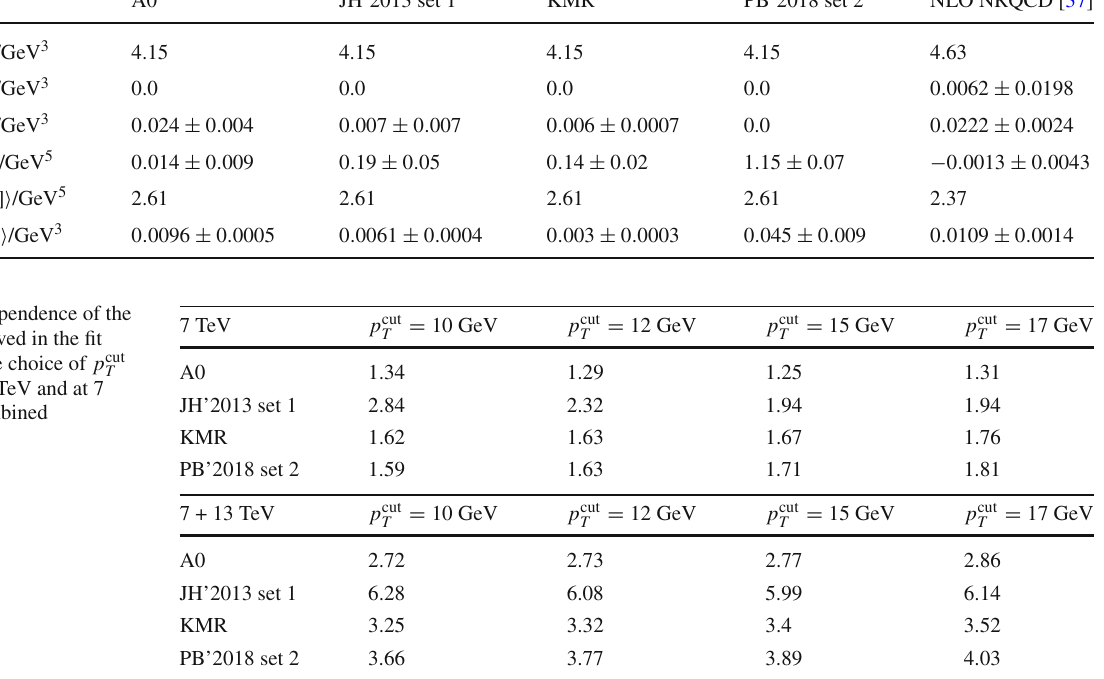
Table 2 The NMEs for ϒ( 2 S ) and χ b ( 2 P ) mesons as determined from our fit at p cut are shown for comparison